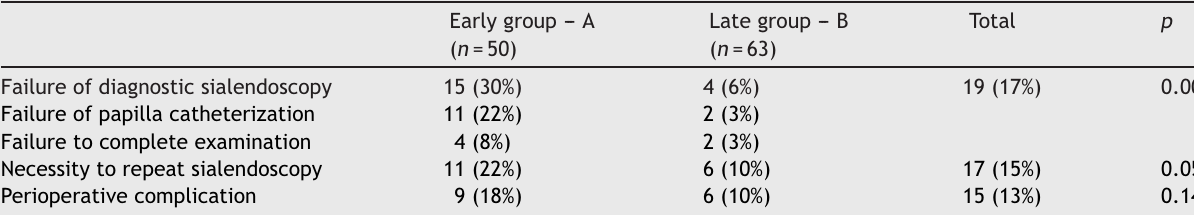
Comparison of perioperative outcomes between groups of early and late sialendoscopy